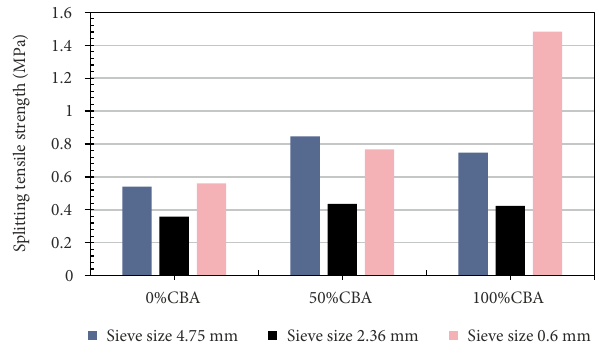
Figure 5. Influence of CBA replacement ratio on the splitting tensile strength of LFC